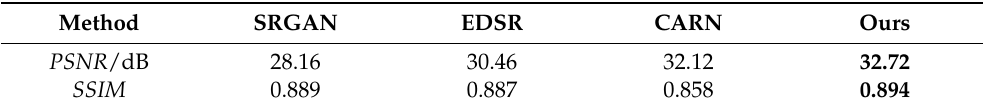
Table 2. Super-resolution results of different